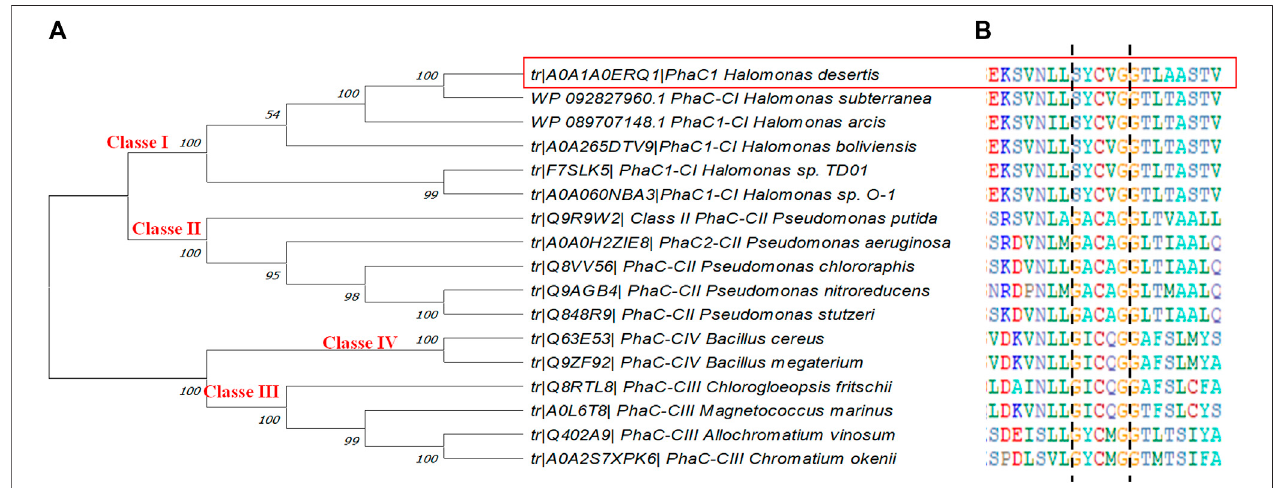
FIGURE 6 | (A) Phylogenetic tree of PhaC1 from H. desertis G11 with reported PHA synthases. The tree was constructed using Mega-X software. (B) Multiple alignments of partial amino acid sequences of PHA synthases exposing lipase box-like patterns from different bacterial species. All the sequences are available on the Universal Protein Resource (UniProt) database. Highlighted sequences correspond to PhaC1 of H. desertis G11.